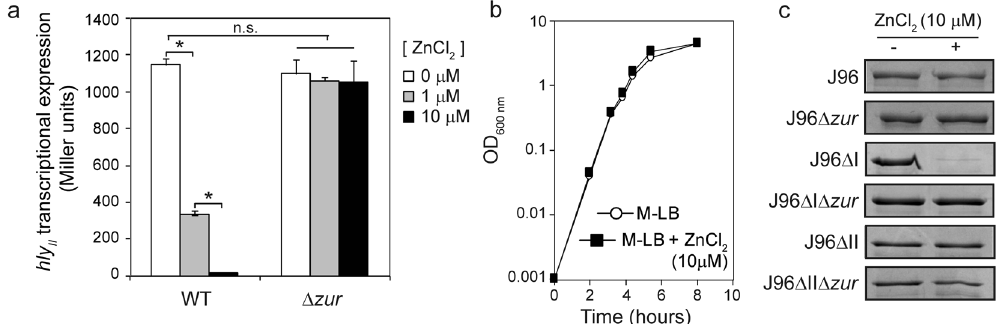
Figure 4. The expression of the hly II operon of J96 responds to the external levels of zinc. ( a ) Transcriptional expression from the hly II promoter in cultures of the strains JFV3 and its zur:: Cm R mutant derivative (EV46) grown in M-LB and M-LB replenished with either 1 or 10 μ M ZnCl 2 . Culture samples were taken at late-log growth phase (OD 600 nm of 1.0). β -galactosidase activity (expressed in Miller units) was determined from three independent cultures; mean values with standard deviation are plotted. * P < 0.05, ANOVA with Tukey’s multiple comparisons test ( b ) Growth curves of JFV3 strain cultured in M-LB and in M-LB replenished with 10 μ M ZnCl 2 . Growth was monitored by measuring OD 600 nm from two independent cultures; mean values are plotted.( c ) Detection of the α -hemolysin in secreted protein extracts from cultures of J96, JFV21 (J96 Δ I) and JFV16 (J96 Δ II) strains and their otherwise isogenic zur mutants (EV27, EV34 and EV38) grown in M-LB and M-LB replenished with 10 μ M ZnCl 2 . Full-length gel images are shown in Fig.